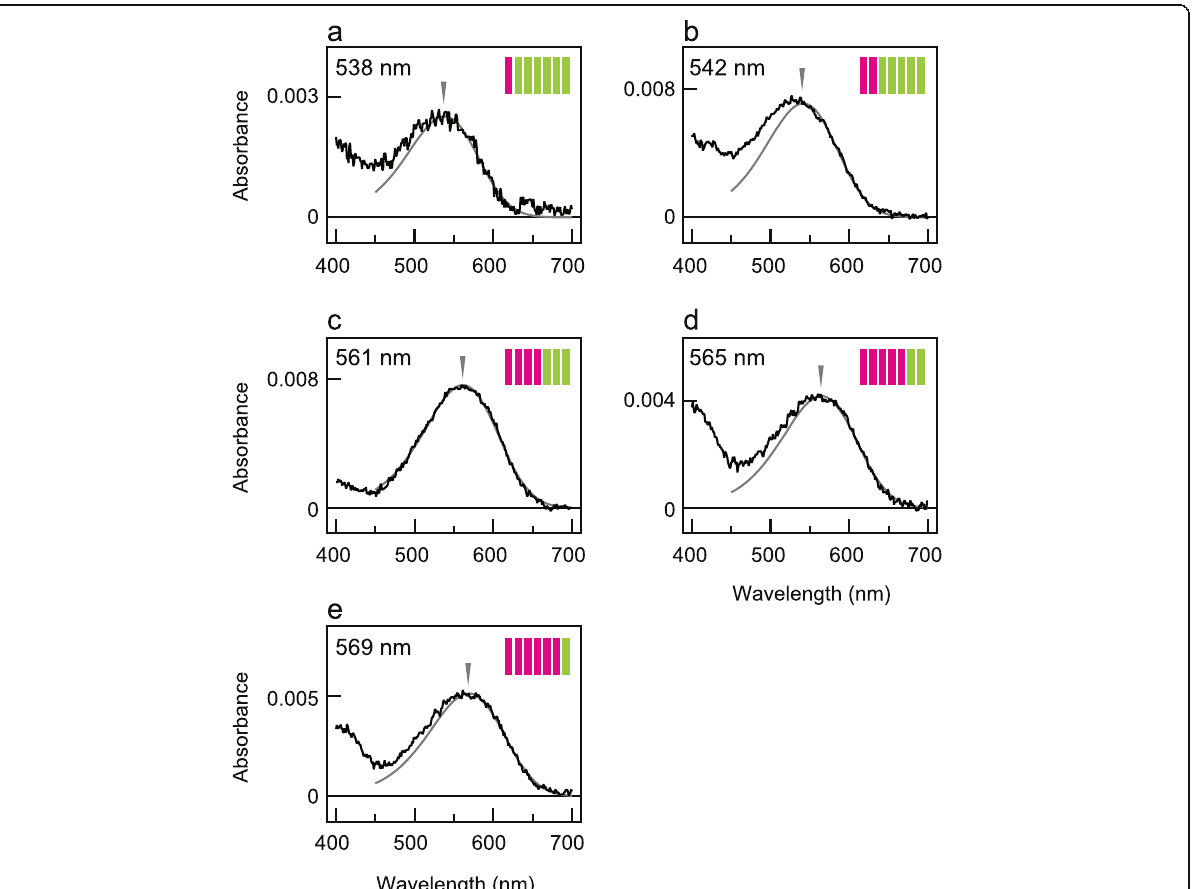
Fig. 3 Absorption spectra of purified chimeric mutants of PxRh1 and PxRh3. Absorption spectra of purified chimeric mutants with respect to the transmembrane helix between PxRh1 and PxRh3 WTs, Rh3(I)/Rh1(II-VII) ( a ), Rh3(I,II)/Rh1(III-VII) ( b ), Rh3(I-IV)/Rh1(V-VII) ( c ), Rh3(I-V)/Rh1(VI,VII) ( d ), Rh3(I-VI)/Rh1(VII) ( e ). Estimated sensitivity curves calculated using rhodopsin nomogram (grey curve) and their absorption maxima (arrowheads) are also shown. Schematic drawings of seven transmembrane structures of butterfly opsins are also shown, in which helices of PxRh1 and PxRh3 are indicated by green and magenta,